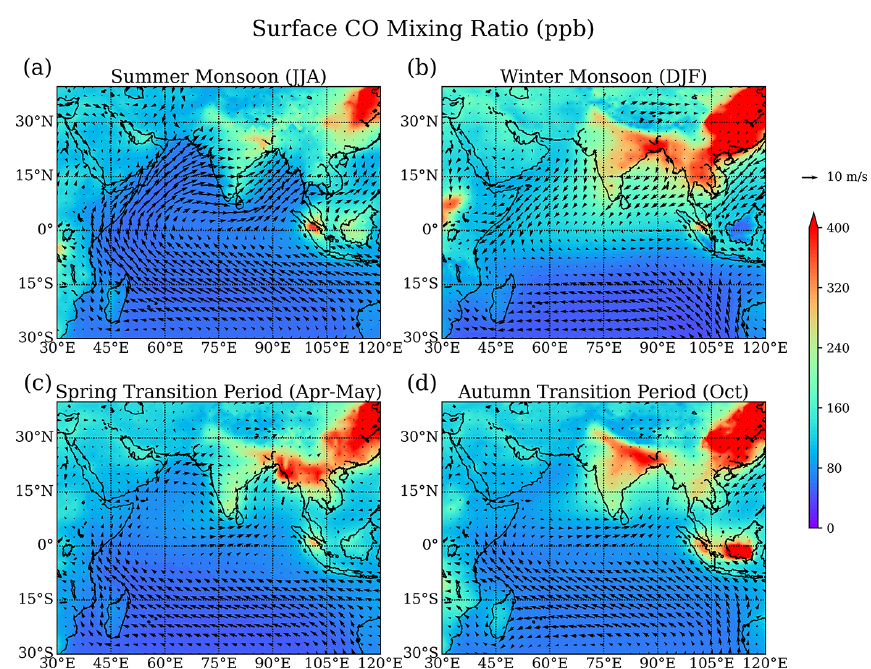
Figure 11. Surface carbon monoxide (CO) mixing ratios from MOPITT (colored shading) and surface wind from ERA-Interim (black